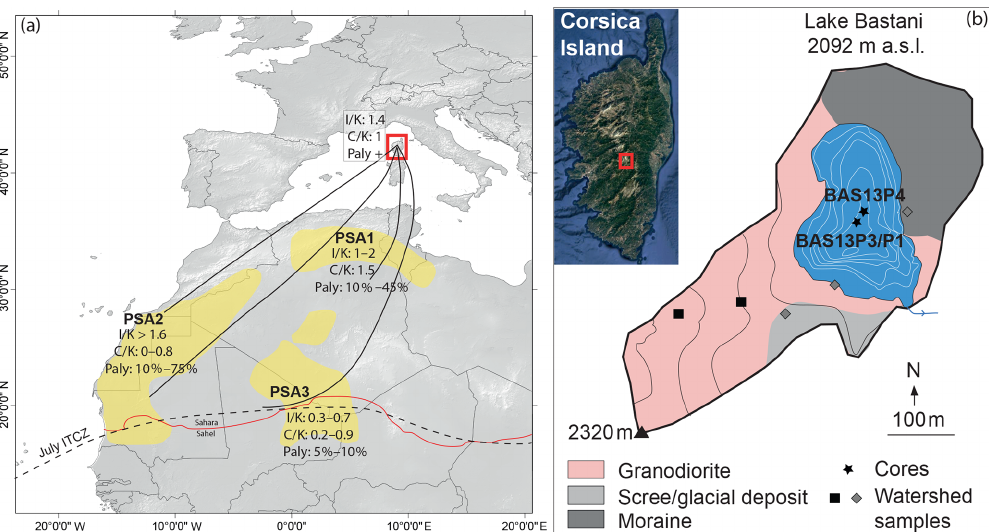
Figure 1. (a) Map of the western Mediterranean area showing major potential source areas for northwestern African dust (PSA1, PSA2, PSA3) with a clay mineral ratio (illite to kaolinite and chlorite to kaolinite) and palygorskite content (Bout-Roumazeilles et al., 2007; Formenti et al., 2011; Scheuvens et al., 2013). Black curves are the main back trajectories for the dust event collected on Corsica (study area, red rectangle); modified from Guieu et al. (2002). The dotted line represents the summer (July) ITCZ position. (b) Aerial photography of Corsica with the localization of Lake Bastani. The Lake Bastani bathymetry map and its watershed with the localization of the three studied cores (BAS13P1, BAS13P3, BAS13P4) and samples on the watershed. In orange is the Sahel–Sahara